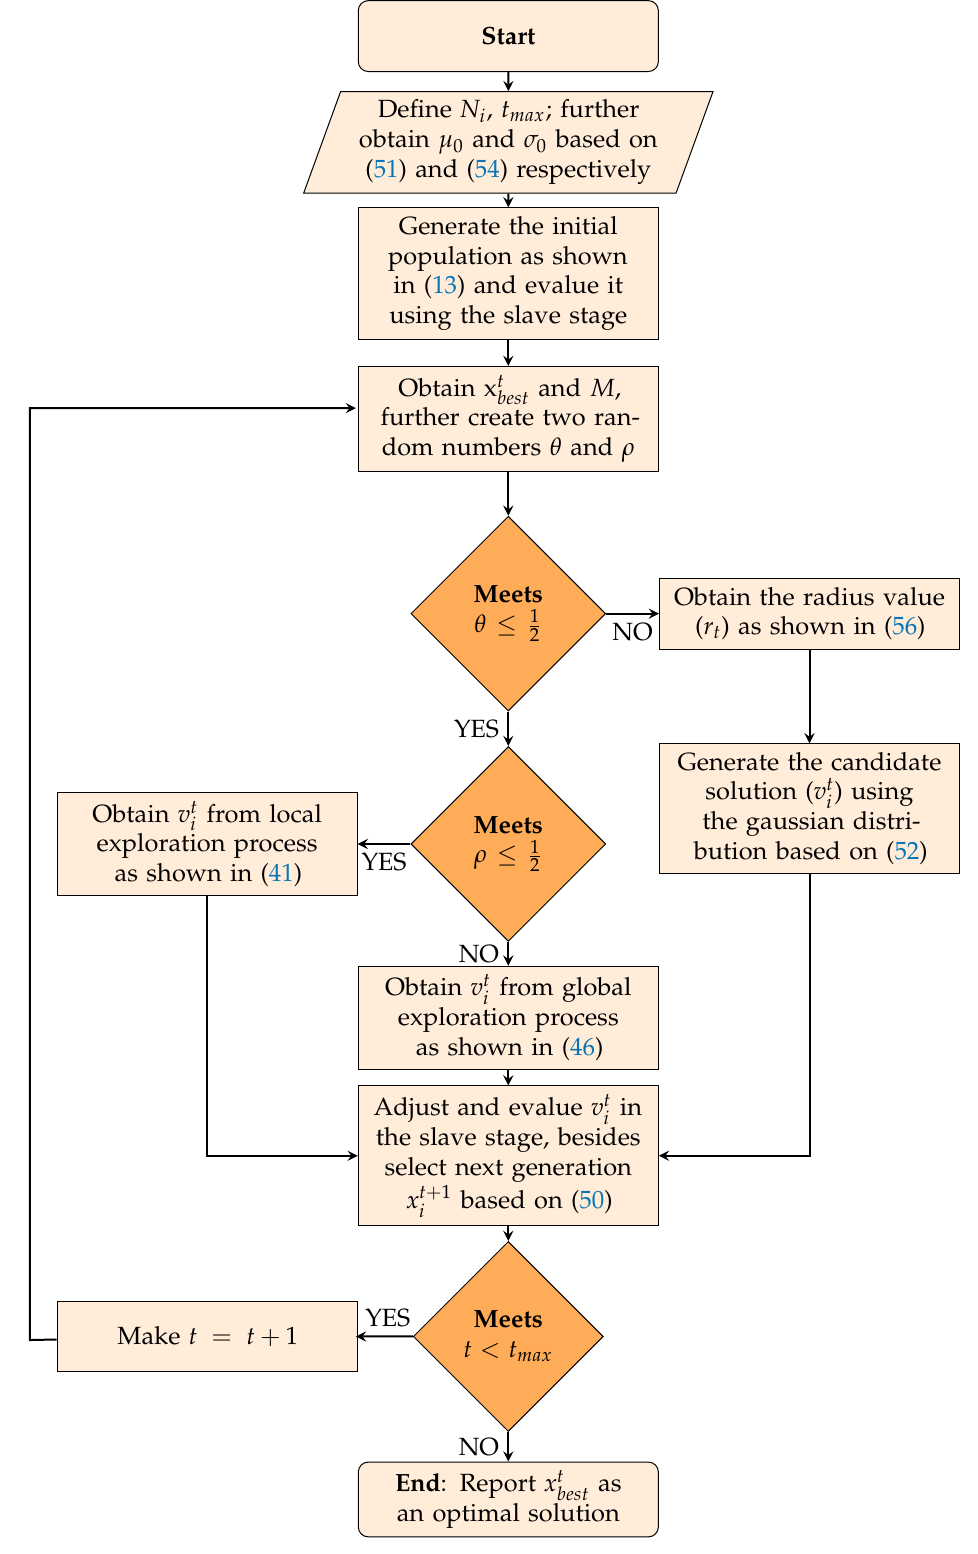
Figure 3. Flowchart used for the improved